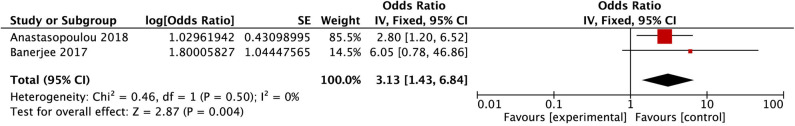
Forest plot for the incidence of CNS leukemia/involvement. There is no obvious heterogeneity between the 2 records.